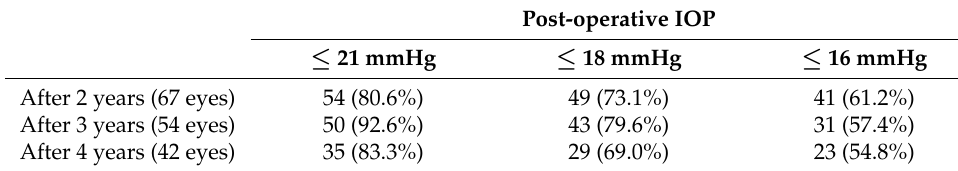
Table 1. Qualified success rates after 2, 3 and 4 years.